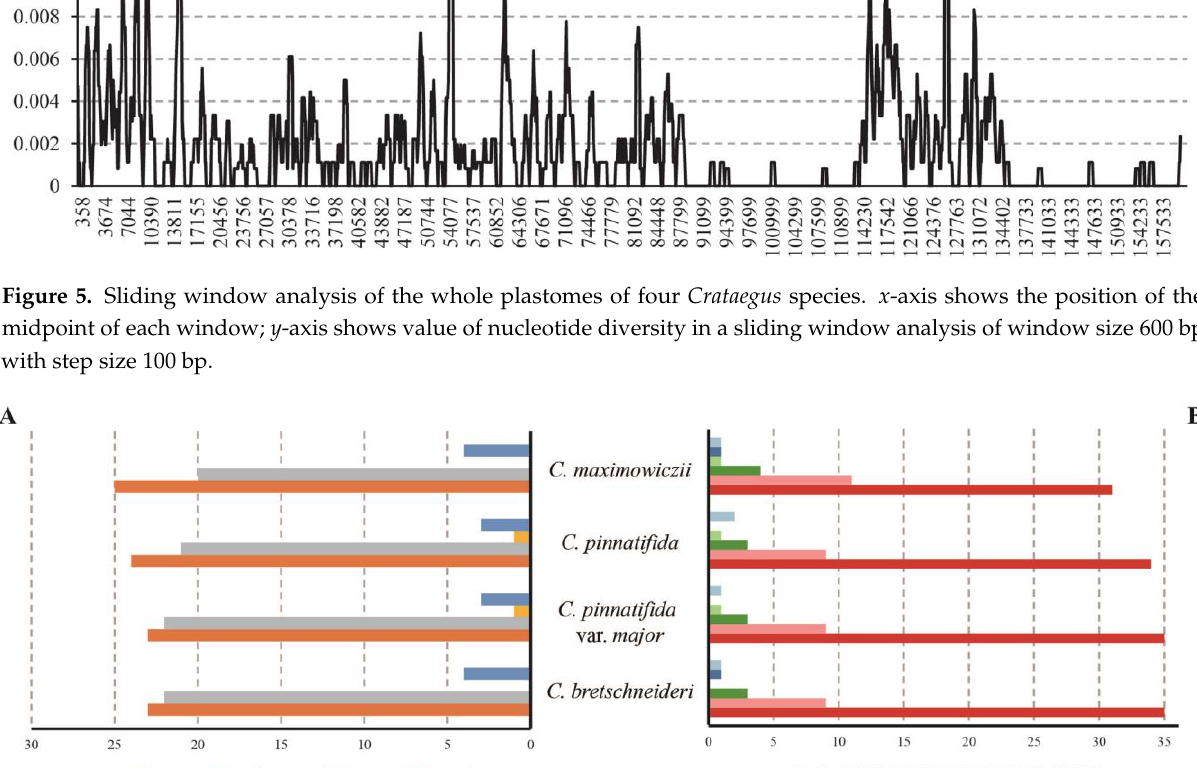
Figure 5. Sliding window analysis of the whole plastomes of four Crataegus species. x -axis shows the position of the mid- point of each window; y -axis shows value of nucleotide diversity in a sliding window analysis of window size 600 bp with step size 100 bp.